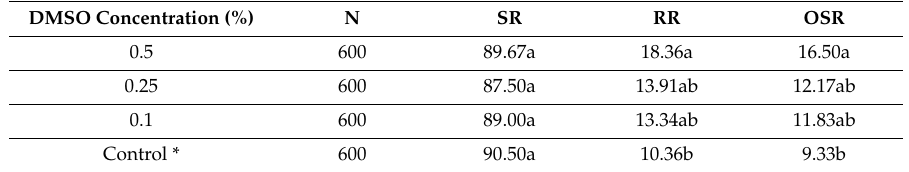
Table 5. E ff ect of di ff erent concentrations of dimethyl sulfoxide (DMSO) on success rates through